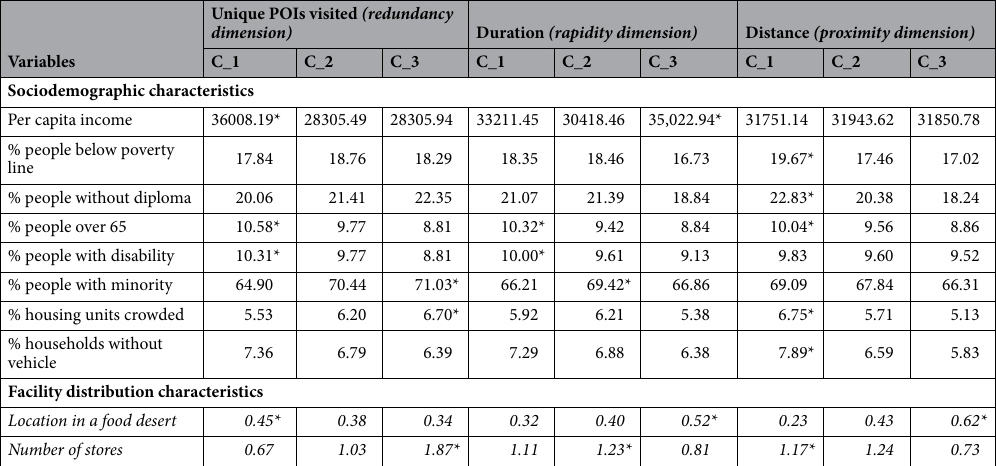
Table 3. Properties of the clusters of access indicators during the normal period. The asterick (*) identifies values which were statstically significant at p < 0.05.